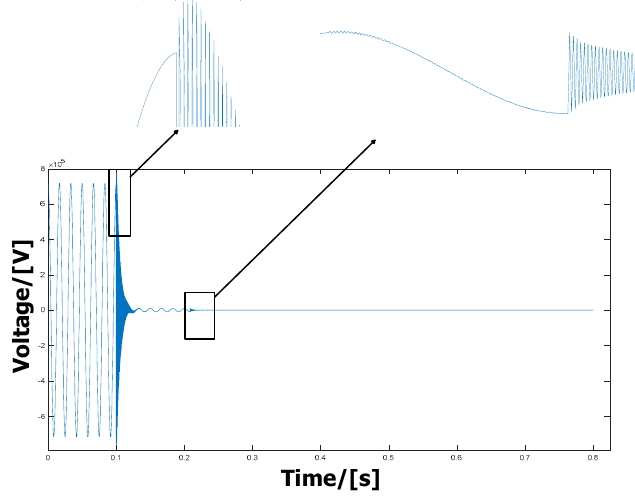
Figure 5. Voltage signal due to the permanent fault.